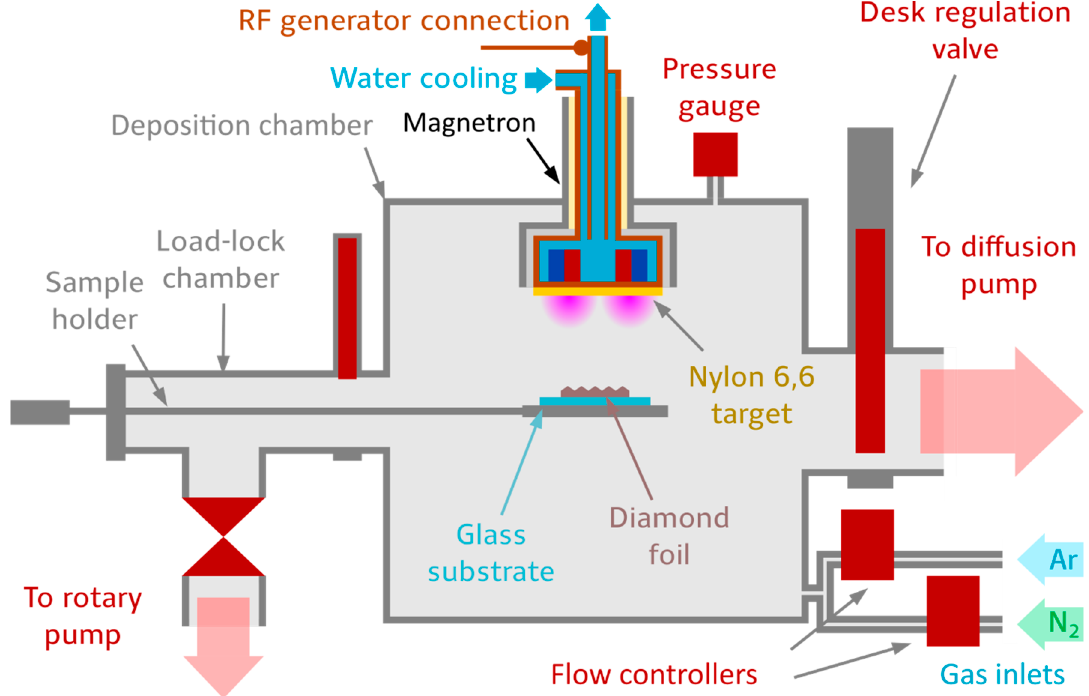
Figure 1. Deposition setup for nanodiamond overcoating with a C:H:N:O film. The load-lock system ensures a high-quality vacuum and good quality thin films because there is no need to vent the chamber before each deposition. The chamber is equipped with a planar 3-inch magnetron, the gas is introduced into the chamber by flow controllers, and the pressure is regulated by a desk regulation valve connecting the chamber and vacuum pump.